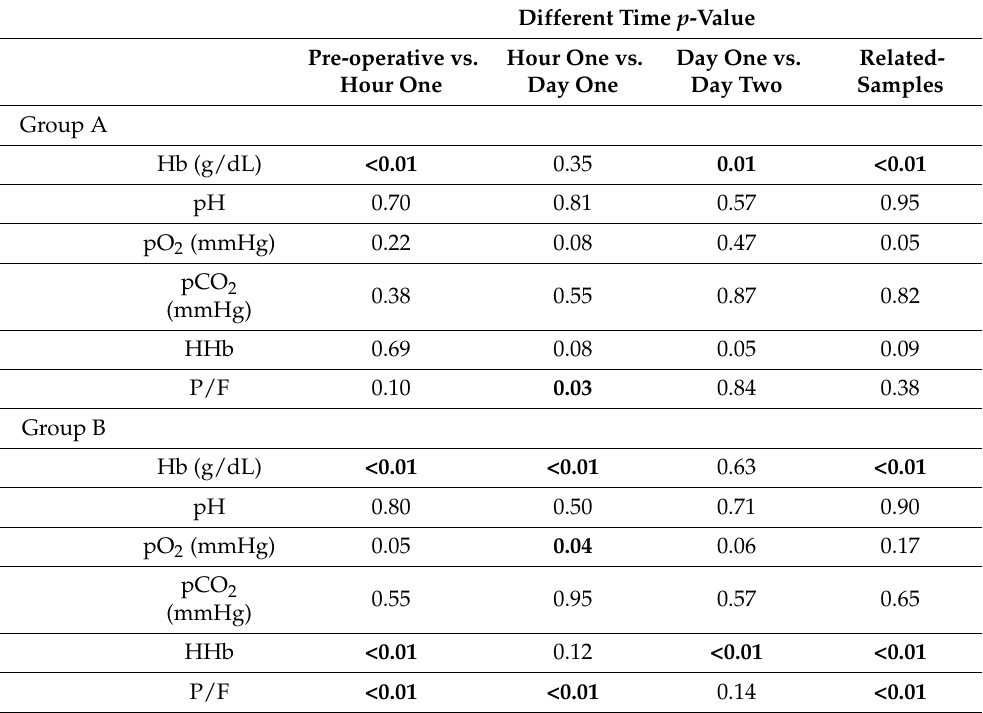
Table 7. Differences between variables within each study group (Wilcoxon test and Related-Samples